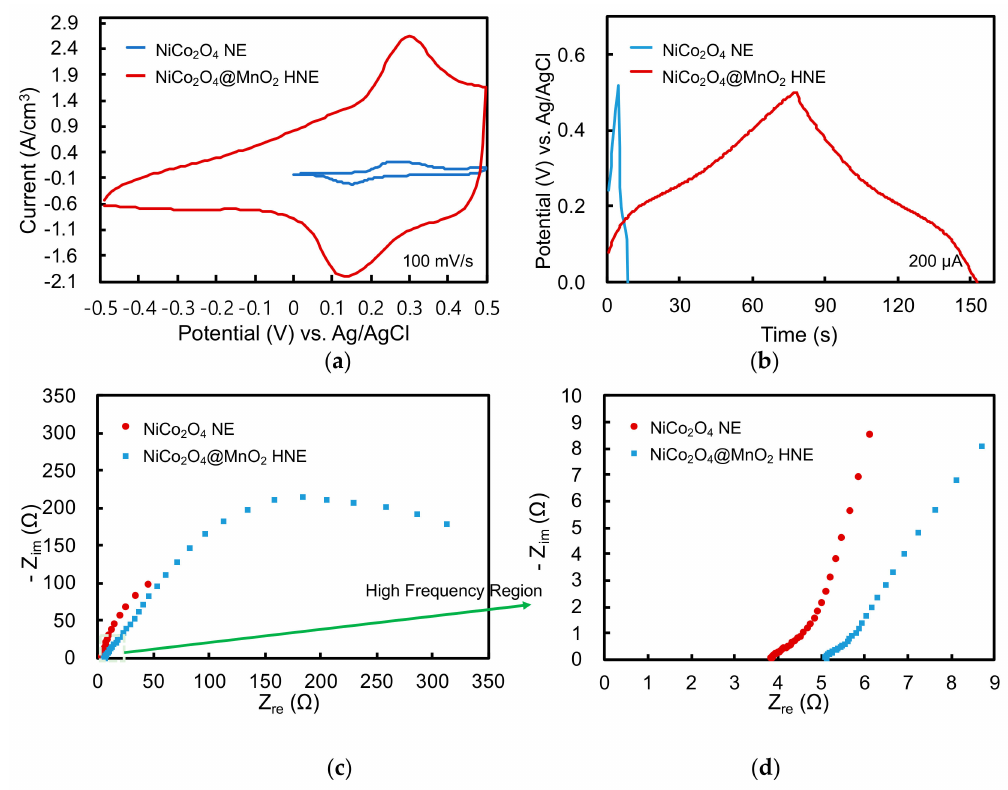
Figure 10. ( a ) The CV curve of an etched-Ni-wire-based NiCo 2 O 4 nanoneedle electrode (NE) and an etched-Ni-wire-based NiCo 2 O 4 / MnO 2 hierarchical nanostructured electrode (HNE) at a 0.1 V s − 1 scan rate; ( b ) GCD curve of the nanostructured electrodes at 200 µ A charging and discharging current; electrochemical impedance spectroscopy (EIS) of the nanostructured electrodes at 100 kHz and 0.01 Hz under 0.5 V in the ( c ) full frequency and ( d ) high frequency